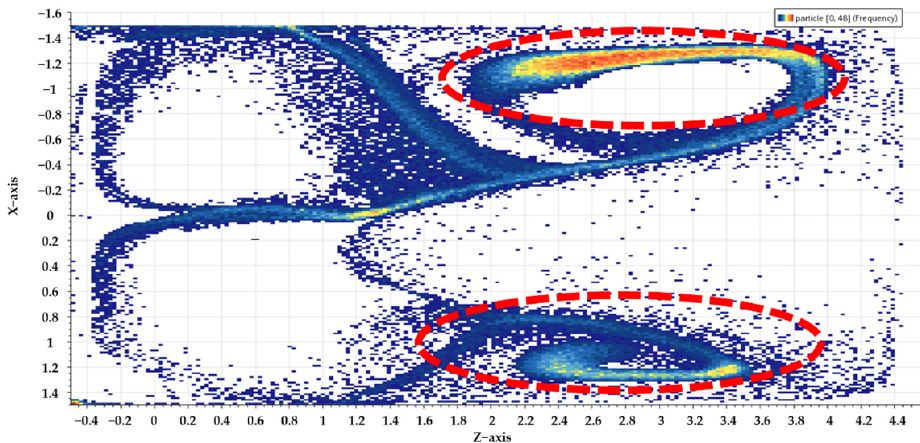
Figure 21. Thermal map of particles distribution in the region of 5 mm from the bottom of pool. The uniformity of the horizontal distribution of particles is calculated to be 0.81.